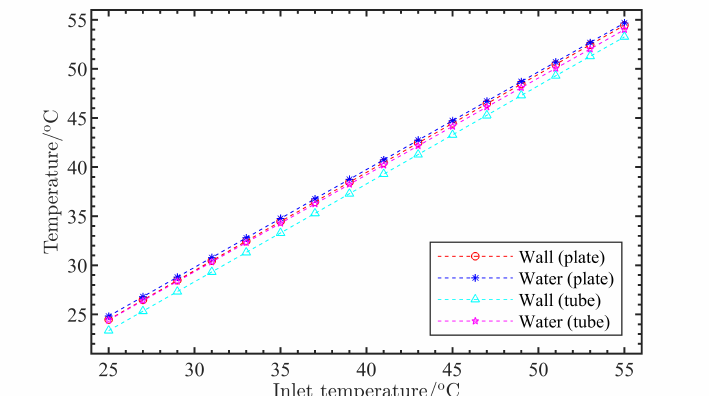
Figure 5. Plots of the surface and water temperature at the outlet of the heat exchanger, with respect to the inlet water